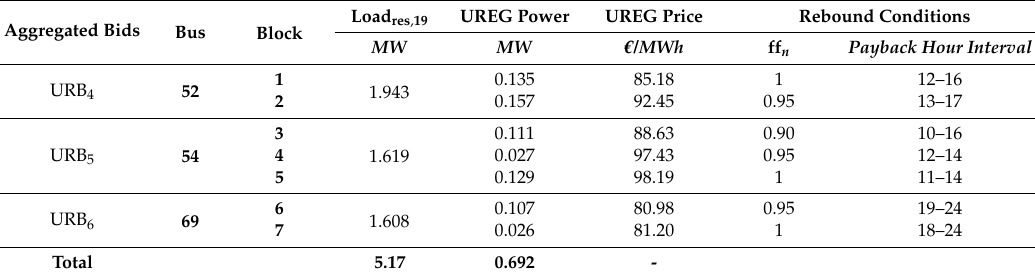
Table 9. Residential area flexibility at hour